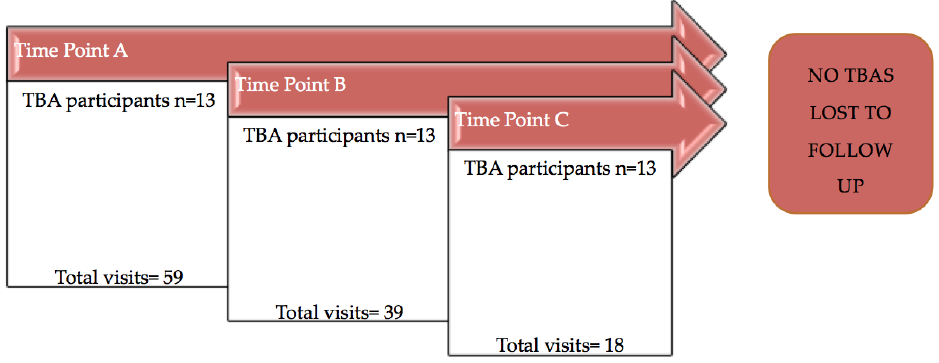
Figure 1. The total participants and observed visits over the study period.